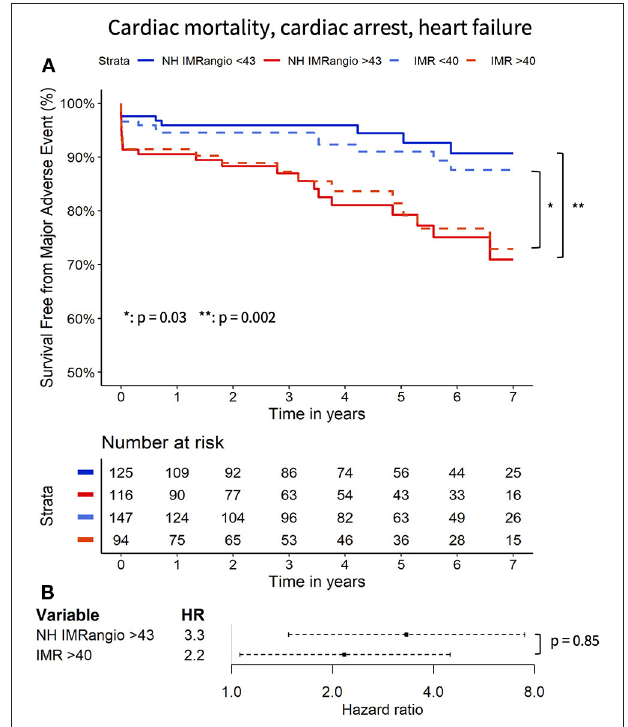
FIGURE 2 | Kaplan Meier curves of freedom from all-cause mortality, resuscitated cardiac arrest, new heart failure diagnosis with high vs. low (i) NH IMR angio and (ii) IMR (A) . Forrest plot displaying the hazard ratio of high (i) NH IMR angio and (ii) IMR (B) . HR, hazard ratio; IMR, index of microcirculatory resistance; NH IMR angio , non-hyperaemic IMR angio .